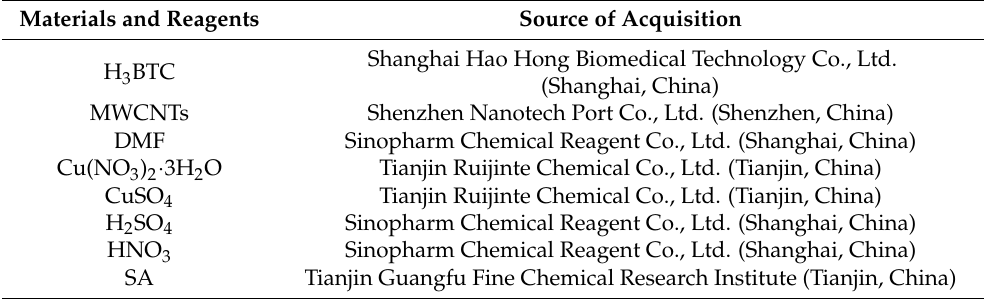
Table 1. Source of materials and